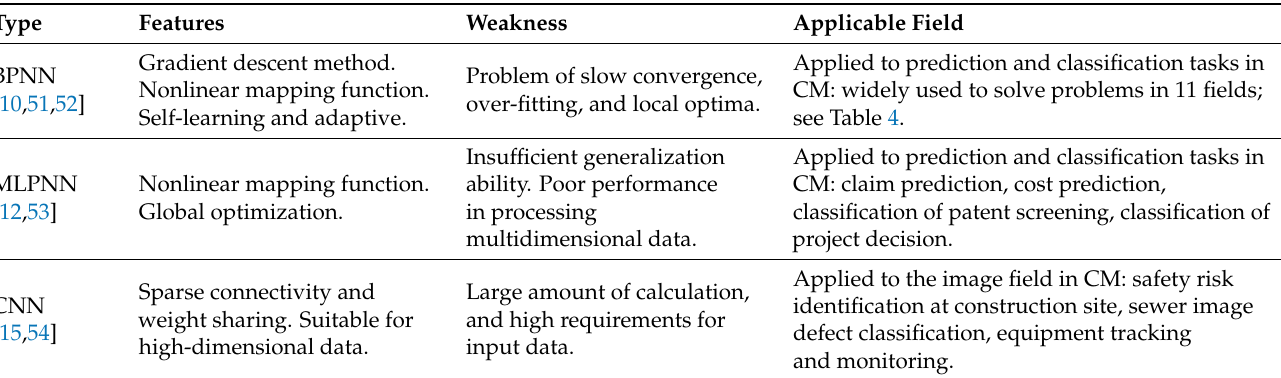
Table 3. Comparison of BPNN, MLPNN and CNN.